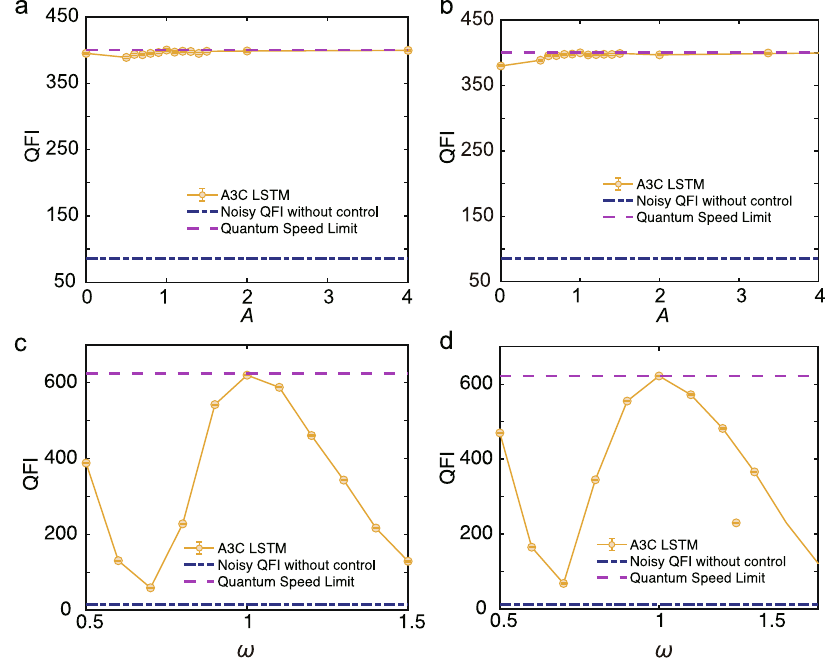
Fig. 9 Transferability results of DRL in terms of estimating A , ω . DRL is trained with A = 1, ω = 1 and the performance is validated on a shift from a broad range of true value. a , b are the results of estimating g where T = 10, Δ t = 0.5, Γ = 0.1 and c , d are for estimating ω where T = 5, = 0.1, Γ = 0. Error bar is the standard error of the Δ t = 0.1, Γ + −